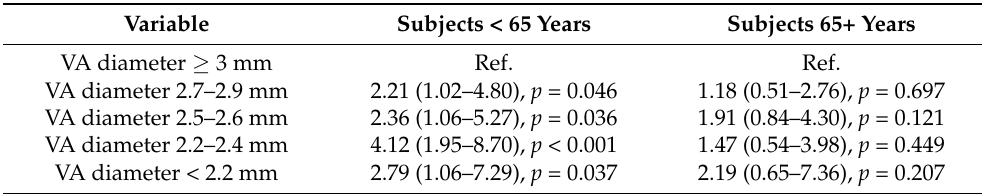
Figure 1. Association of non-dominant vertebral artery diameter and age in the group of patients with cerebral infarction or vertebrobasilar artery syndrome and subjects without symptoms of cerebrovascular accident. Red reference line represents patients with cerebral infarction or vertebrobasilar artery syndrome, blue reference line represents subjects without symptoms of cerebrovascular accident. Table 2. Risk of PCI/VAS by degree of vertebral artery hypoplasia, OR (95% CI), p .